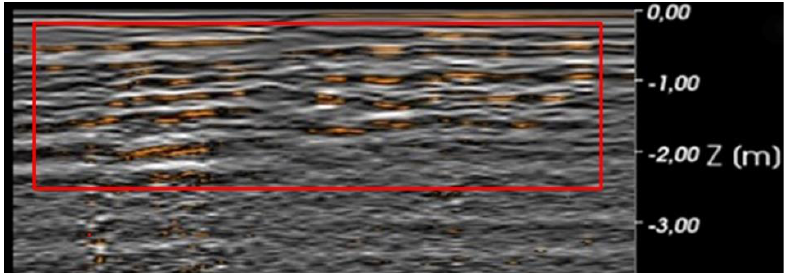
Figure 12. Radargram corresponding to the grid highlighted in red in Figure 11.